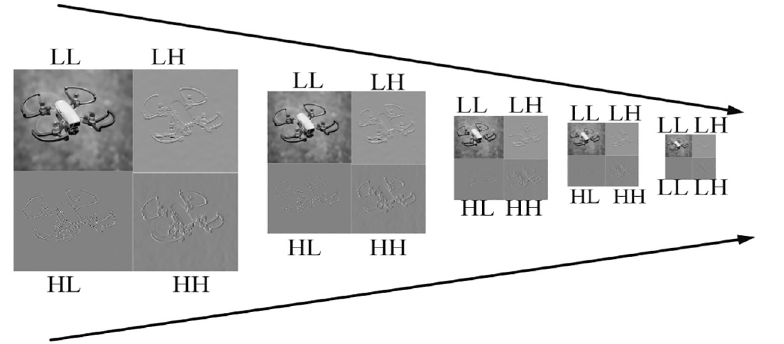
Fig 4. Fifth level DWT